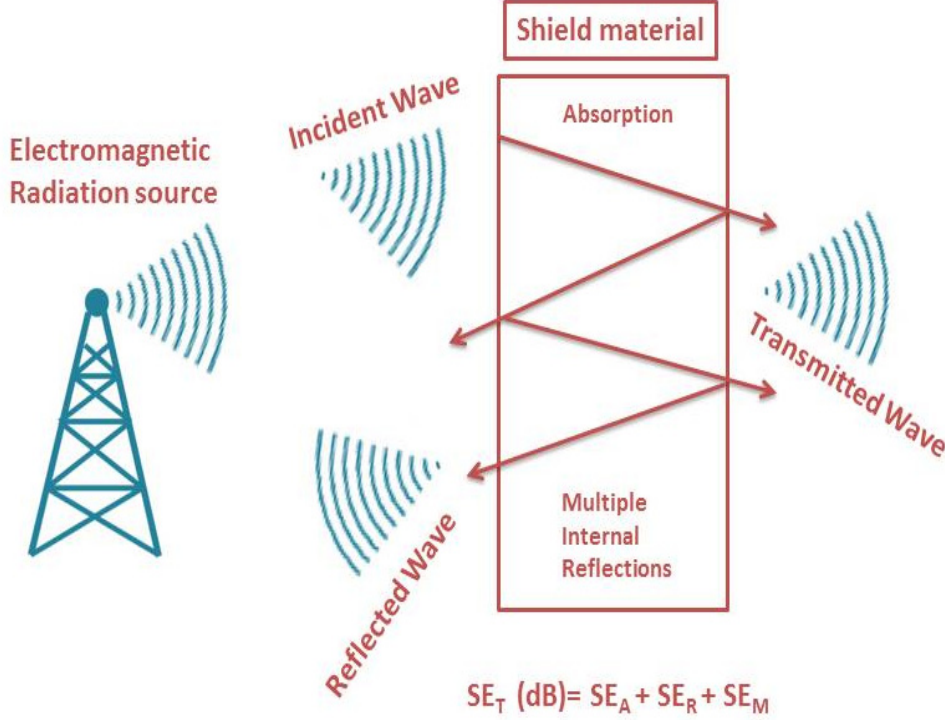
Figure 2. Plausible EMI shielding mechanisms associated with a shield material.